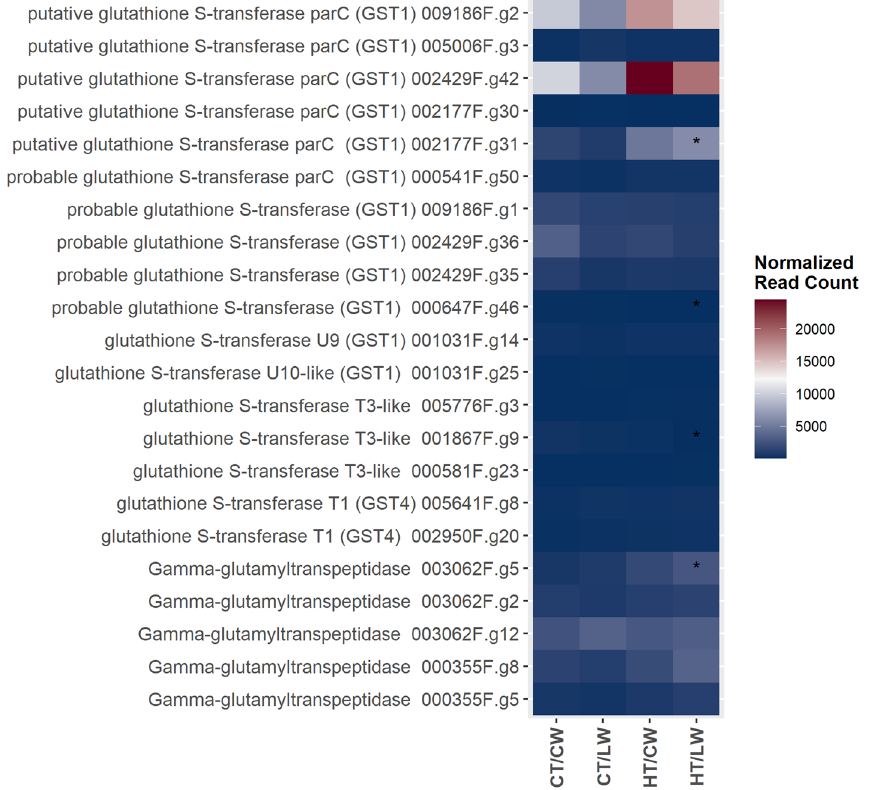
Figure 5. A heatmap of normalized read counts for transcripts putatively identified as glutathione S-transferase, which may contribute to varietal thiol precursor biosynthesis in hop cone. Asterisk (*) indicate the log2-fold change: * > 2 log2-fold change, ** > 4 log2-fold change, *** > 6 log2-fold